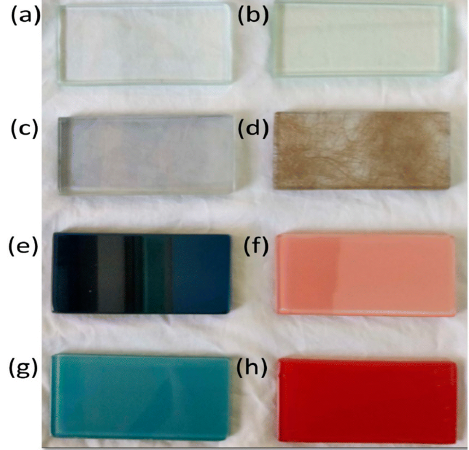
Figure 13. Laminated glass samples showing: ( a ) monolithic clear glass (6 mm), ( b ) transparent film, ( c ) cooling film, ( d ) fabric film, ( e ) reflective film, ( f ) Mist Rose film, ( g ) Tiffany Blue film, and ( h ) scarlet red [47].